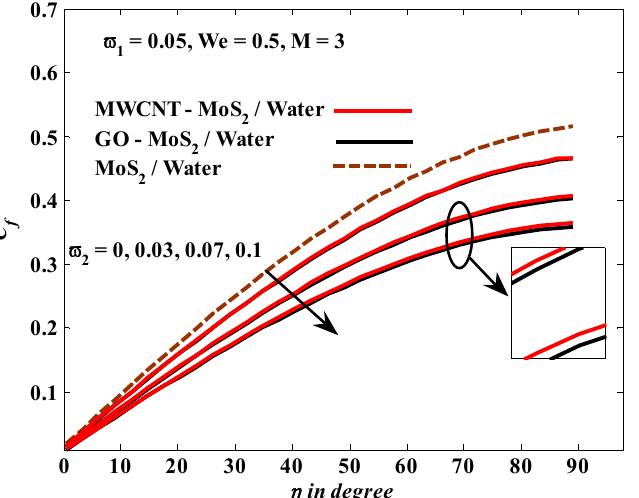
Figure 5. The behavior of hybrid nanofluid’s skin friction under the effect of ultrafine particle volume fraction.